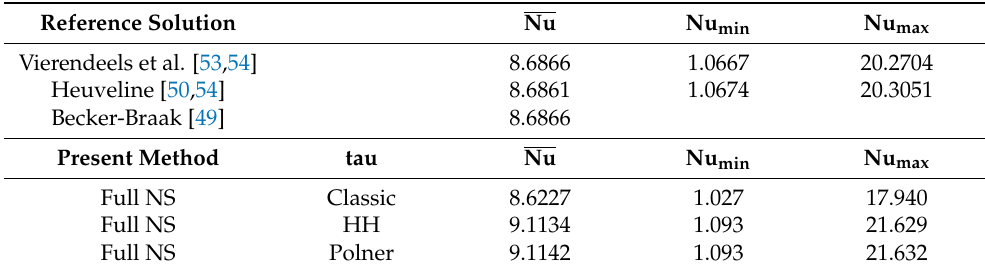
Figure 11. Buoyancy-driven square cavity. Nusselt numbers along hot vertical wall for (cid:101) = 0.6 and Sutherland viscosity. Table 3. Nusselt numbers along hot vertical wall. Ra = 10 6 , (cid:101) = 0.6, Sutherland viscosity. Present methods on a 140 × 140 uniform